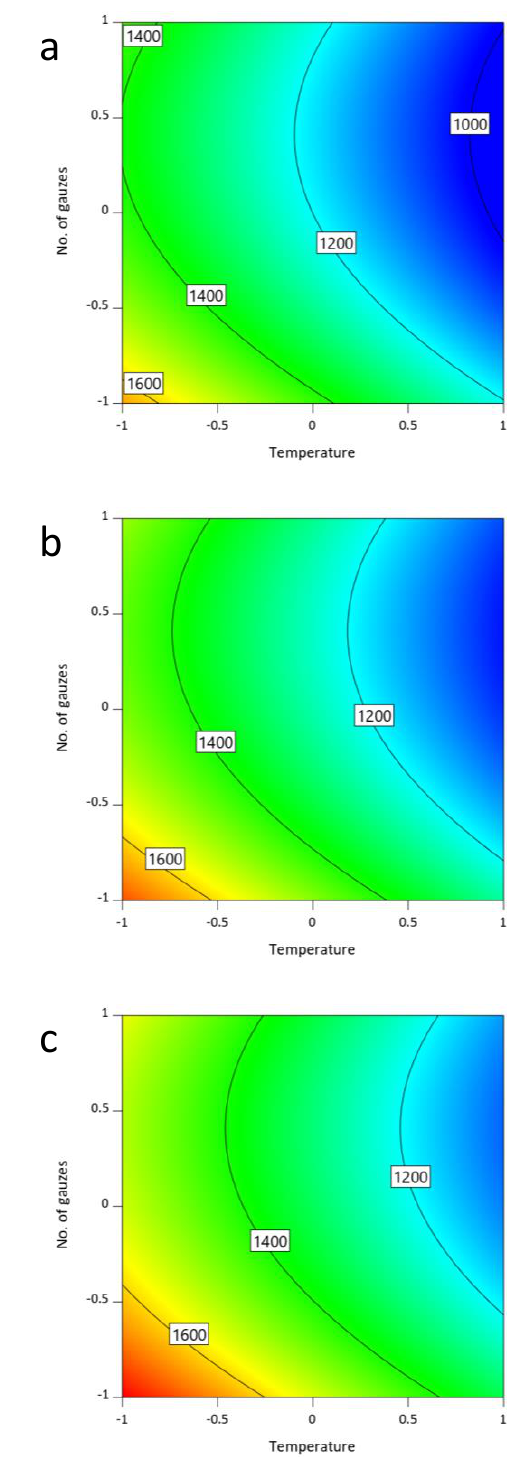
Figure 7. Interaction effect between the temperature ( X 2 ) and the number of catalytic gauzes ( X 3 ) at fixed reactor’s load ( X 1 ) on N 2 O concentration in nitrous gases ( R 2 ) by contour plot. ( a ) X 1 = − 1; ( b ) X 1 = 0; ( c ) X 1 =1.